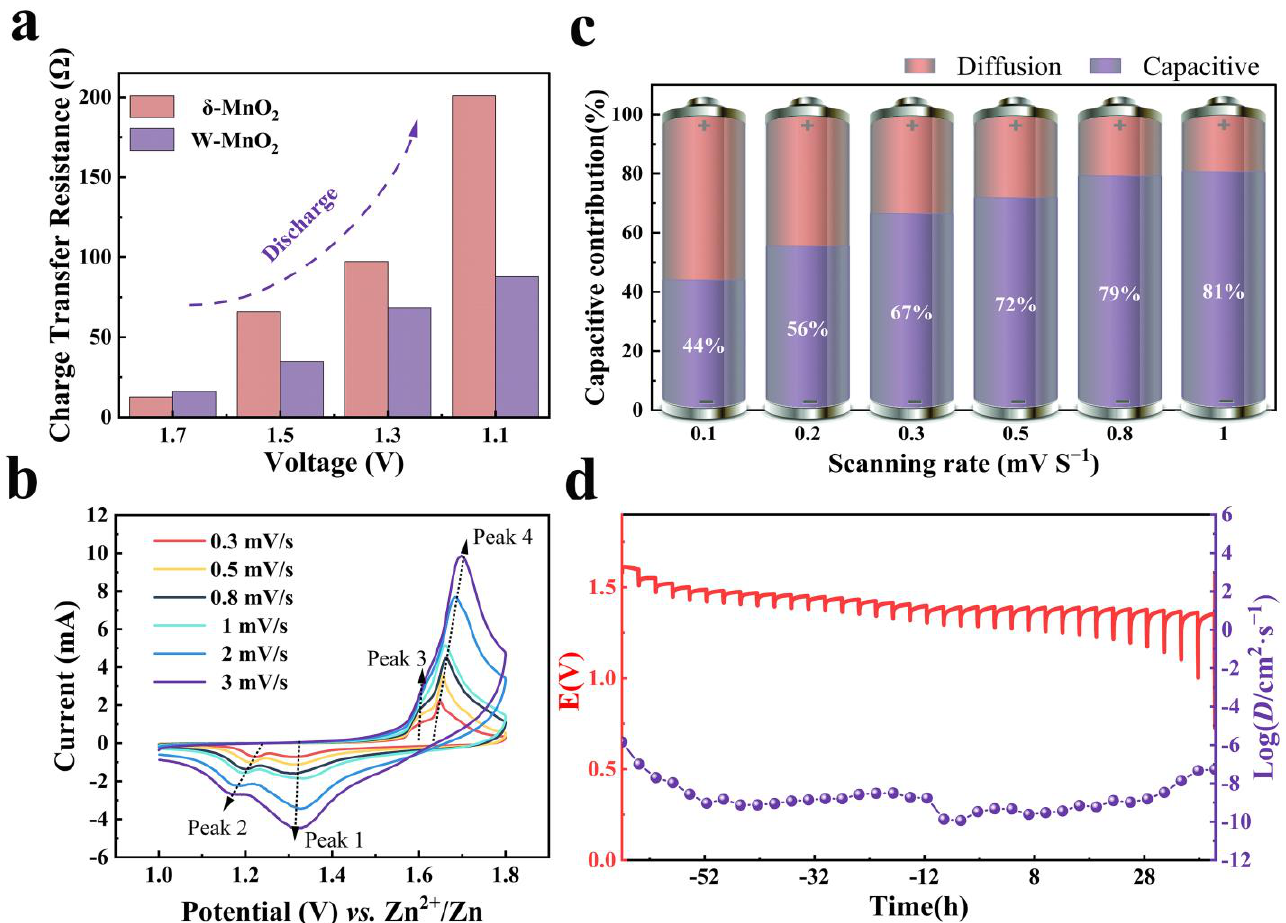
Figure 4. ( a ) The charge transfer resistance of W-MnO 2 and δ -MnO 2 cathodes at the discharge stage. ( b ) CV tests at various scan rates from 0.3 to 3 mV s − 1 . ( c ) The proportion of capacitive contributions at different scan rates for W-MnO 2 . ( d ) GITT curves of the W-MnO 2 cathode after activation during the discharge process.